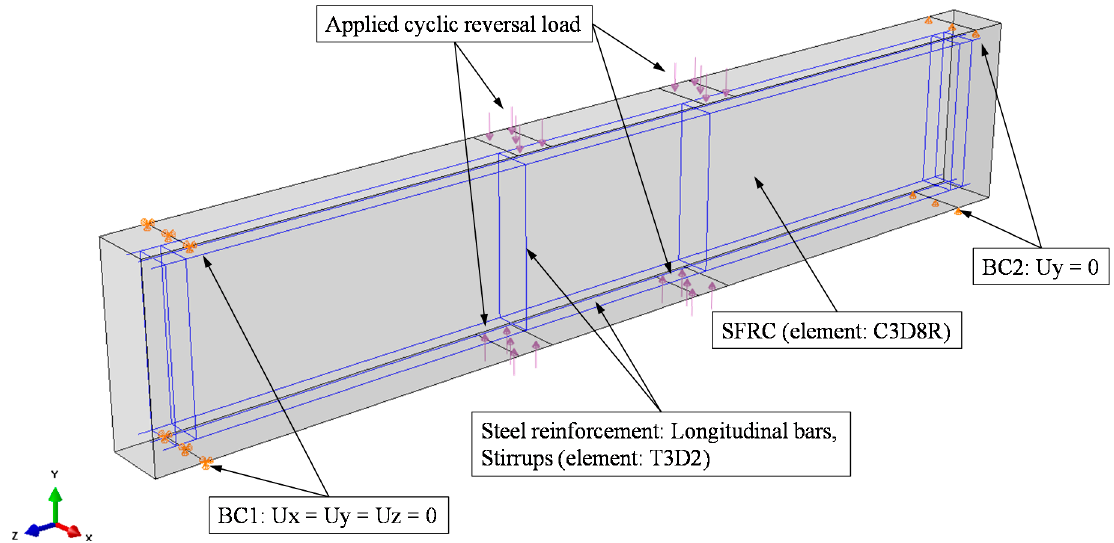
Figure 7. Boundary conditions and loading of the FE simulation of the beam.